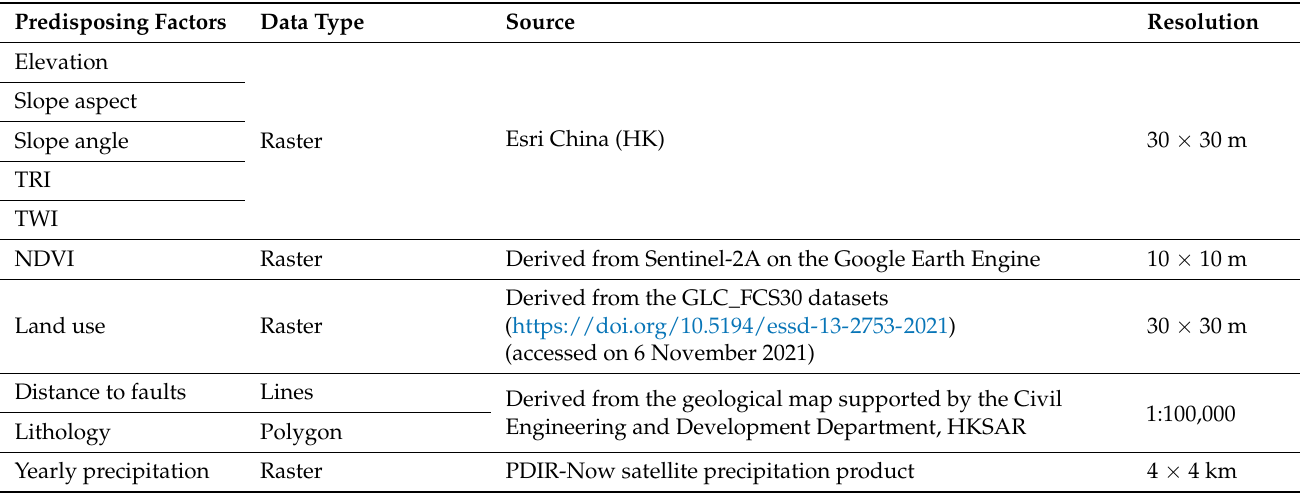
Figure A3. Local magnification of Figure 11 ( a – d ). Table A1. Information of predisposing factors for modeling the Zhangzha Town landslide susceptibility.